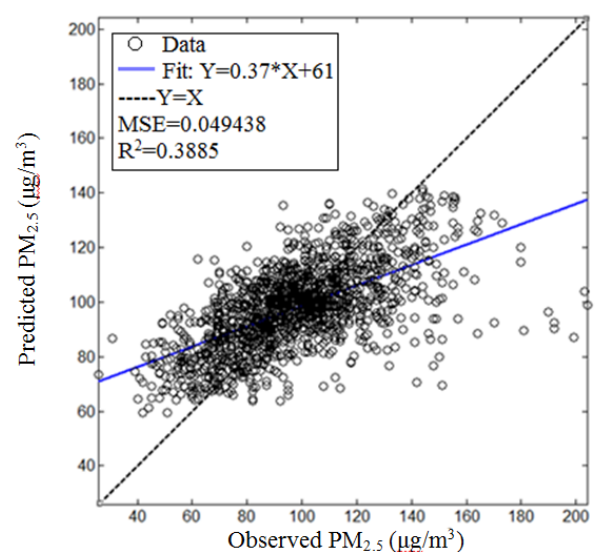
Fig. 4: Scattered plot of the observed and predicted results of PM